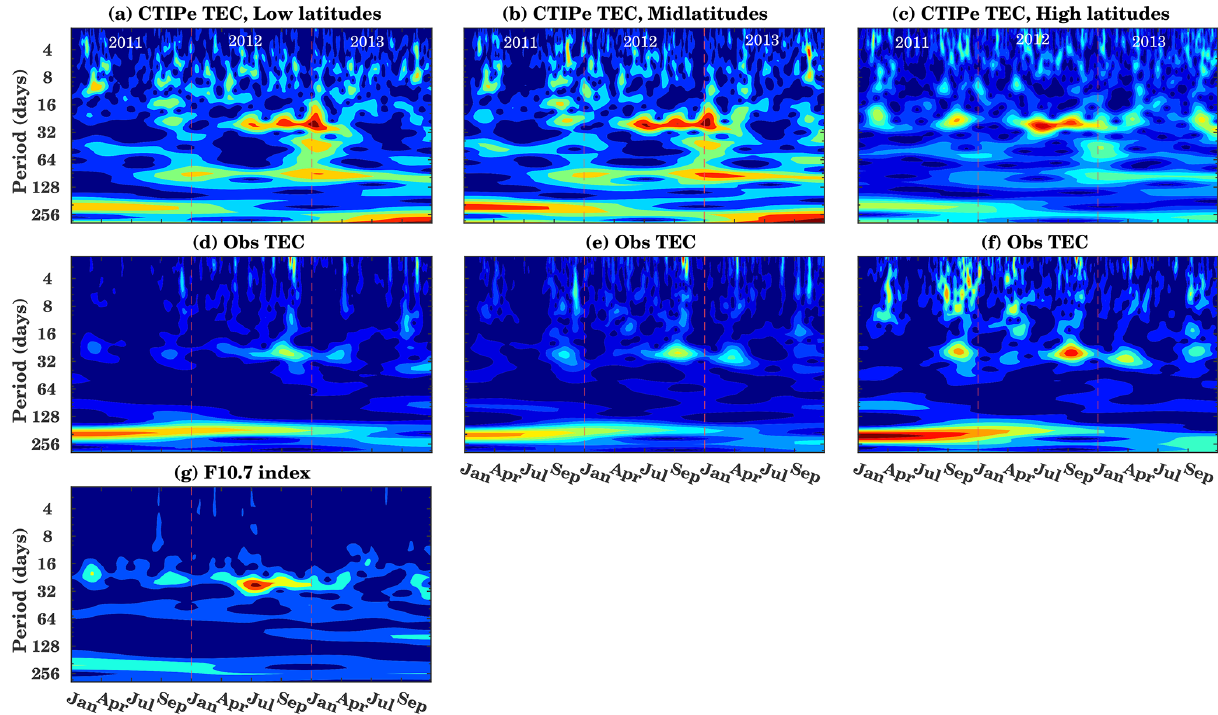
Figure 4. Wavelet continuous spectra of daily modeled TEC (a–c) , observed TEC (d–f) for different low latitudes [ ± 30 ◦ ], midlatitudes [ ± ( 30 ◦ − 60 ◦ ) ], and high latitudes [ ± ( 60 ◦ − 70 ◦ ) ], and (g) F10.7